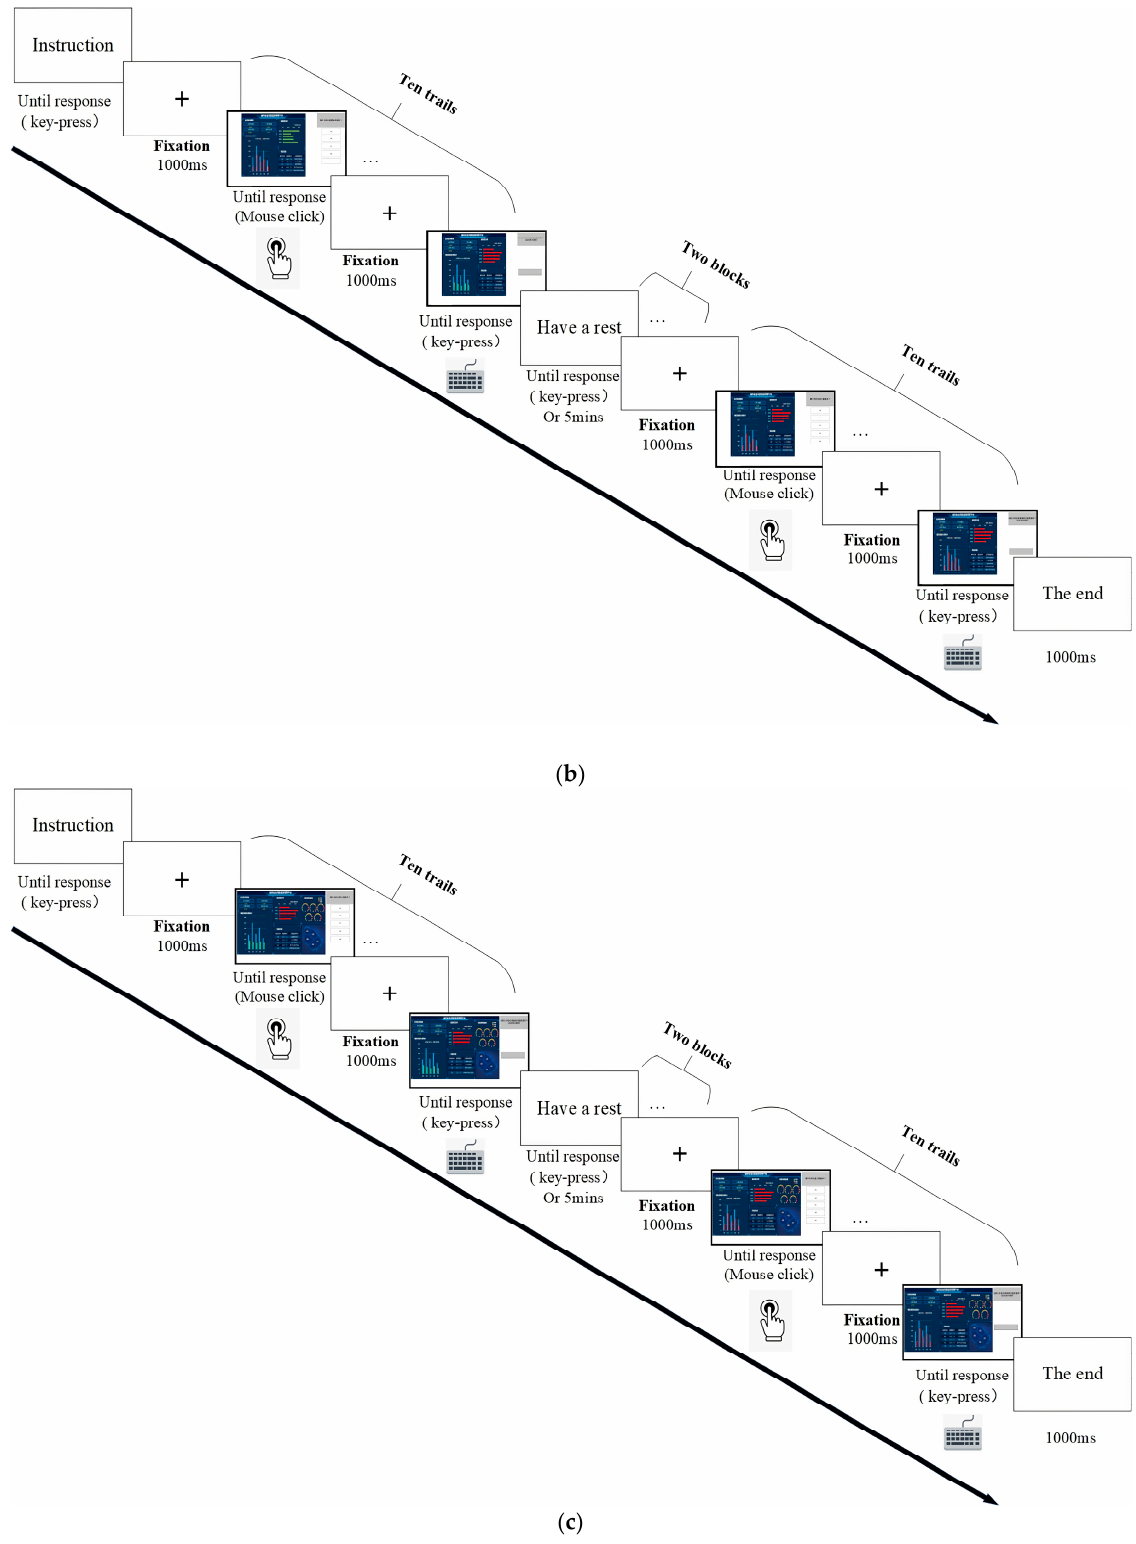
Figure 4. Experiment procedure: ( a ) The procedure of experiment UI1 (contains two contexts); ( b ) the procedure of experiment UI2 (contains four contexts); ( c ) the procedure of experiment UI3 (contains four contexts).